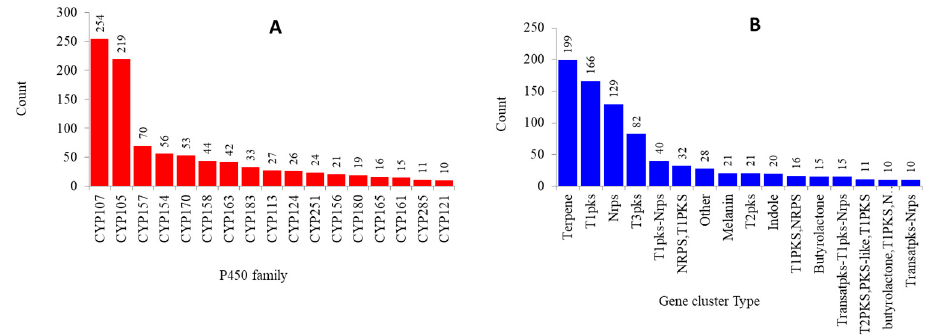
Figure 4. Analysis of P450s associated with secondary metabolite production in Streptomyces species. ( A ) Dominant P450 families (families with higher numbers of members) that are part of biosynthetic gene clusters (BGCs) and ( B ) dominant BGCs (present in higher numbers) containing P450s were presented in the figure. The numbers next to bars indicate the number of P450s in panel A and the number of BGCs in panel B. Detailed information is presented in Supplementary Table S5.